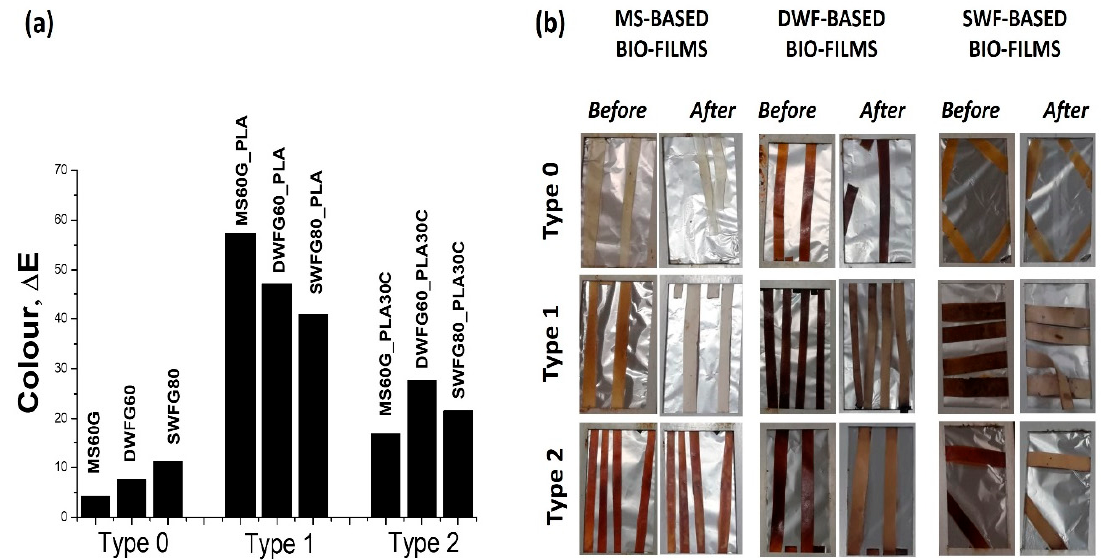
Figure 4. Total color variation ( Δ E) ( a ) and images before and after the QUV ageing ( b ) of the maize starch (MS)-based, durum waste flour (DWF)-based and soft waste flour (SWF)-based prepared bio-